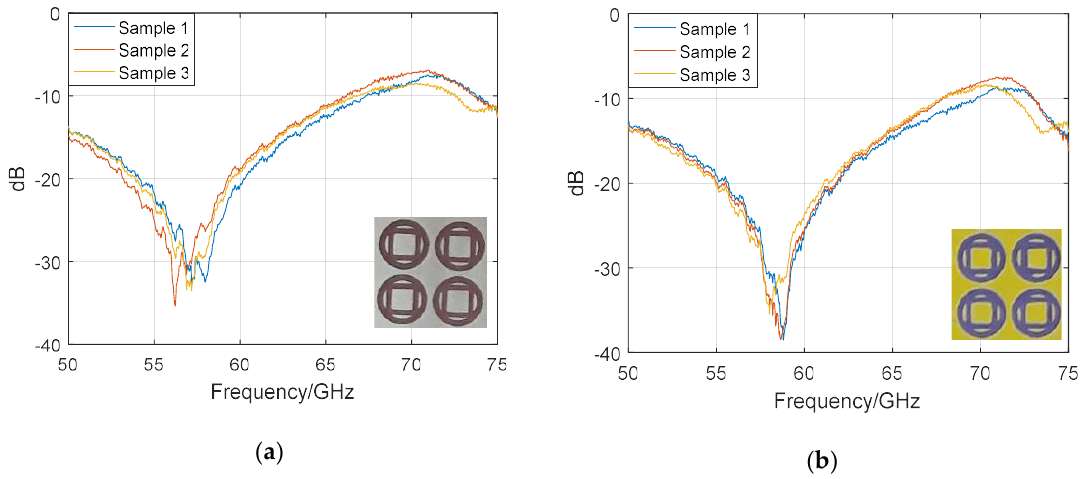
Figure 10. Measured results of the transmission coefficient of the 60-GHz metasurface: ( a ) Melinex based metasurface, ( b ) Kapton based metasurface.